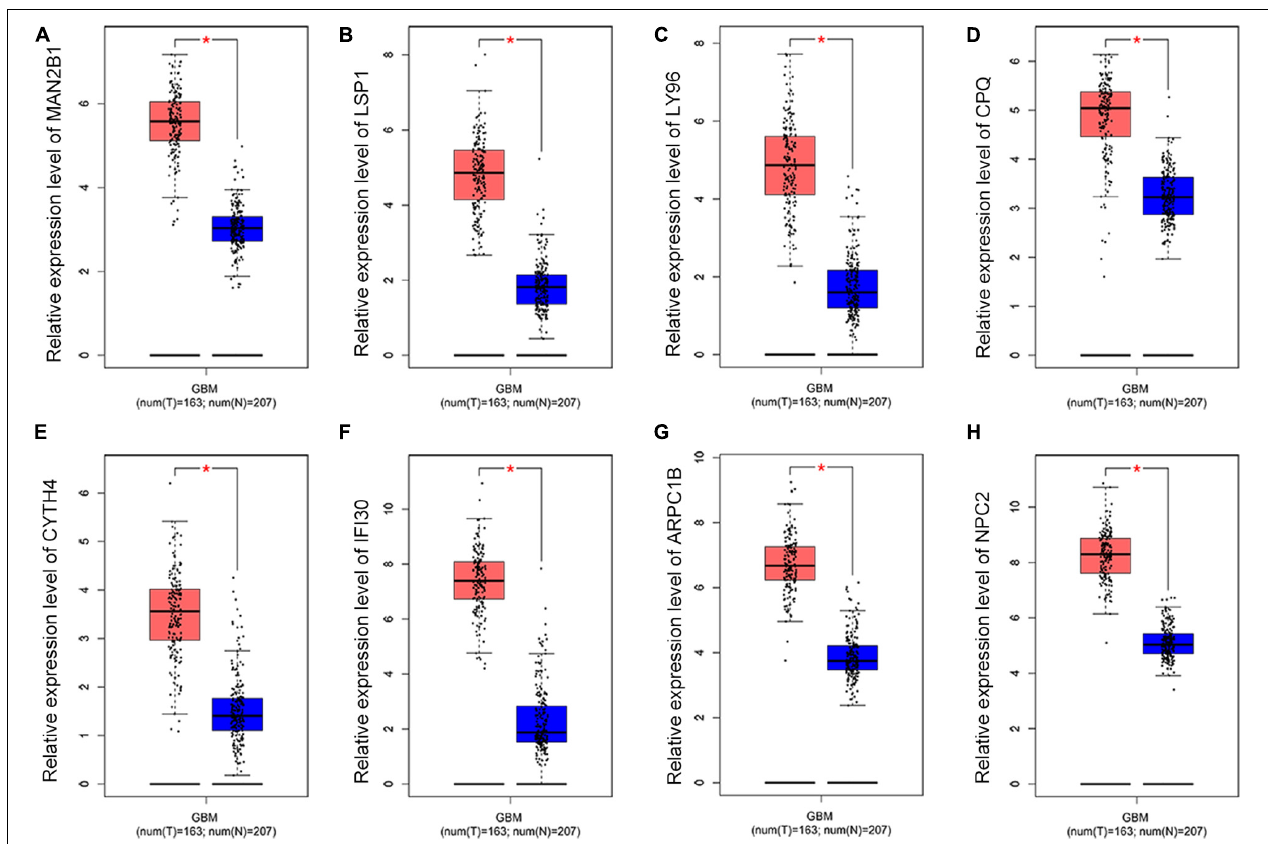
FIGURE 3 | The relative expression level of eight common DEGs. Boxplots illustrating the relative expression level of (A) MAN2B1; (B) LSP1; (C) LY96; (D) CPQ; (E) CYTH4; (F) IFI30; (G) ARPC1B; (H) NPC2 in normal and GBM tissues based on the GEPIA database. *Significant difference, p <